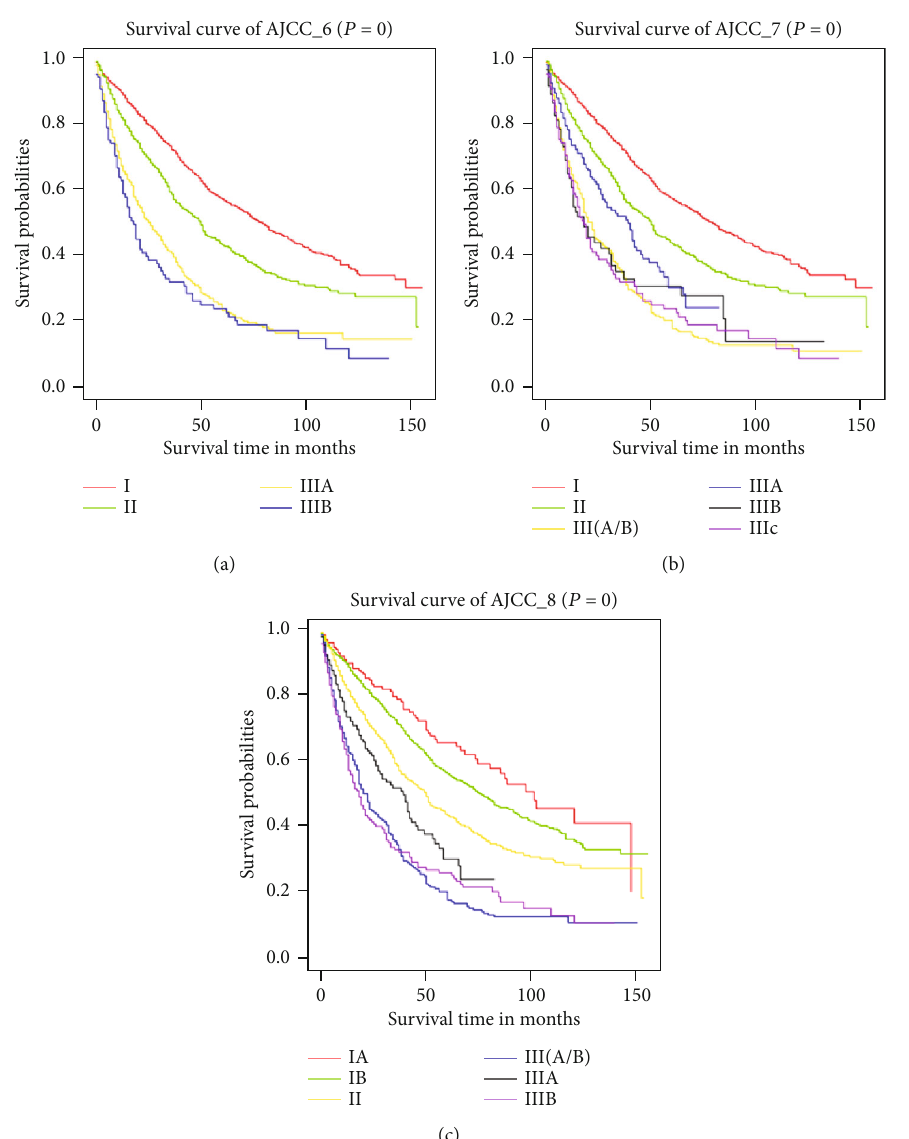
Figure 1: Kaplan-Meier survival curves of the derivation cohorts generated for di ff erent American Joint Committee on Cancer (AJCC) editions. (a – c) AJCC sixth, seventh, and eighth edition,